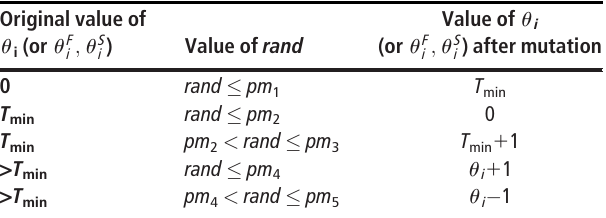
Table 2 The mutation logic of the solving